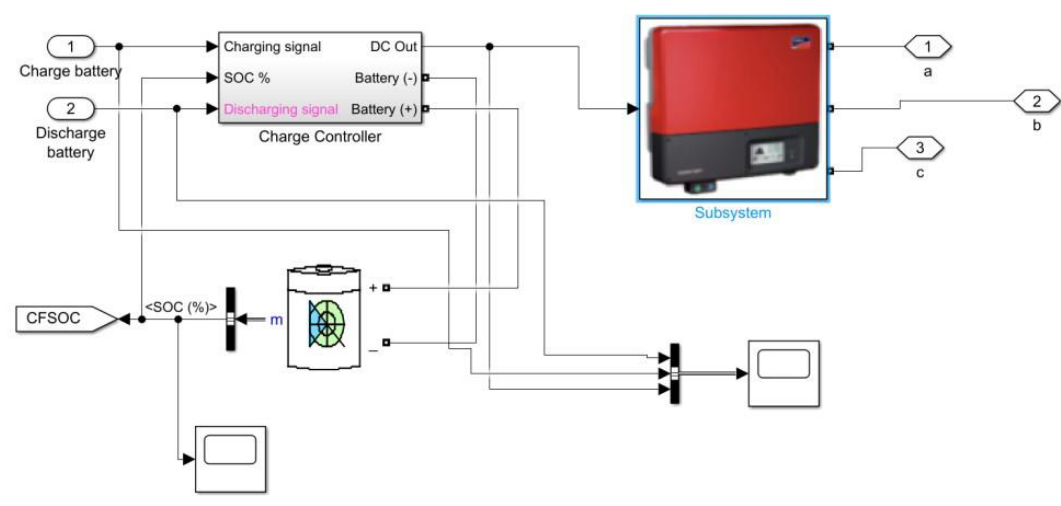
Figure 4. Battery storage model.